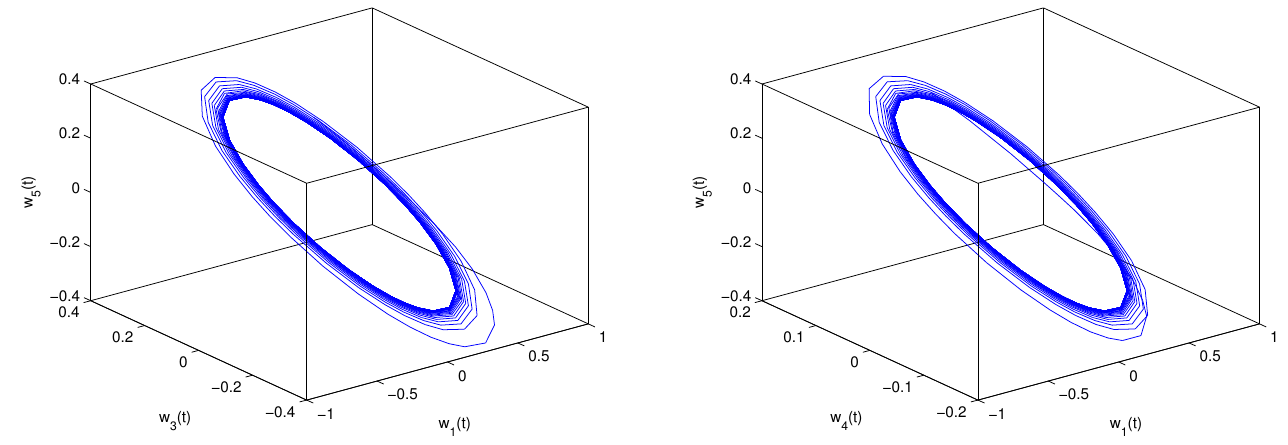
Figure 2. Matlab simulation outcomes for system (71) when ϑ = 0.4 > ϑ 0 = 0.37. System (71)